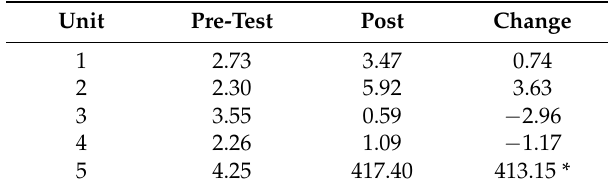
Table 2. Measurements of consistency in PM 2.5 concentration readings between units before and after experiment in µ g/m 3